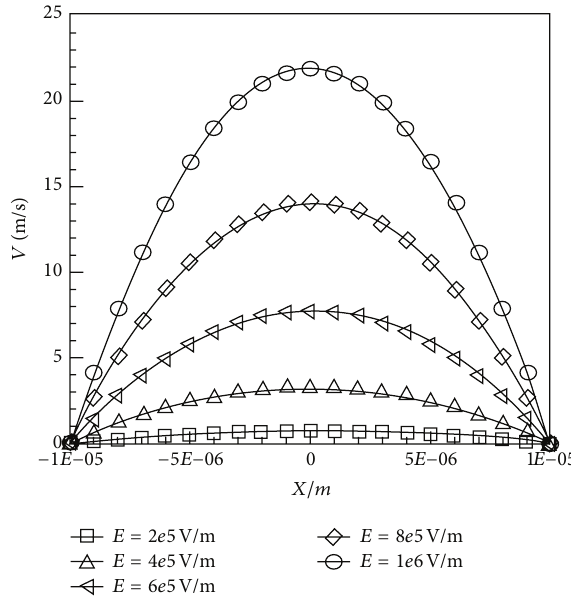
Figure 6: The velocity magnitude profiles under different applied electric